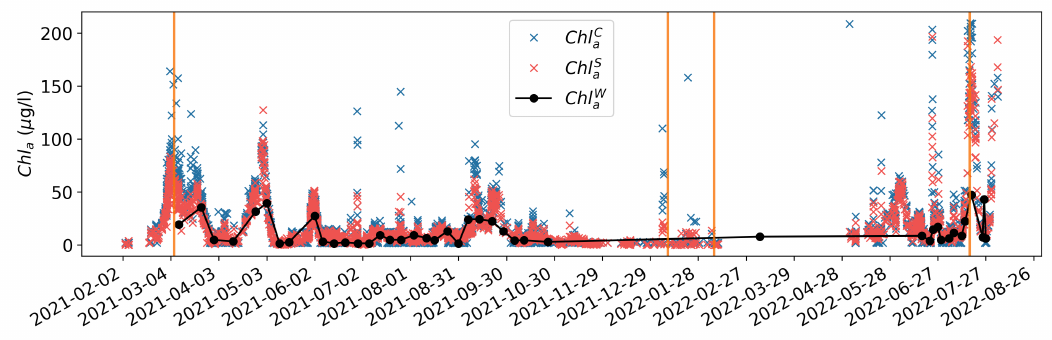
Figure 7. Time series of HYPSTAR-retrieved Chl a concentrations using CRAT and SIMIS algorithms (blue and red dots, respectively), and Chl a concentrations measured from the water sampling points (black) between January 2021 and August 2022. Orange vertical bars point to specific dates discussed in the text and reported in Table 2, i.e., 2021-03-06, 2022-02-07, 2022-01-10, and